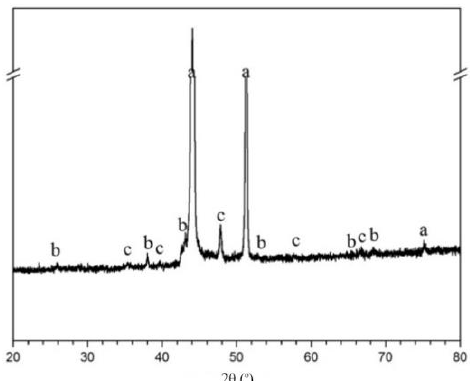
Figure 9. XRD patterns of SN-N5 nanocrystalline coatings after oxidation at 1050 °C for 500 h (a. γ/γ′, b. α-Al 2 O 3 , c. θ-Al 2 O 3 ).